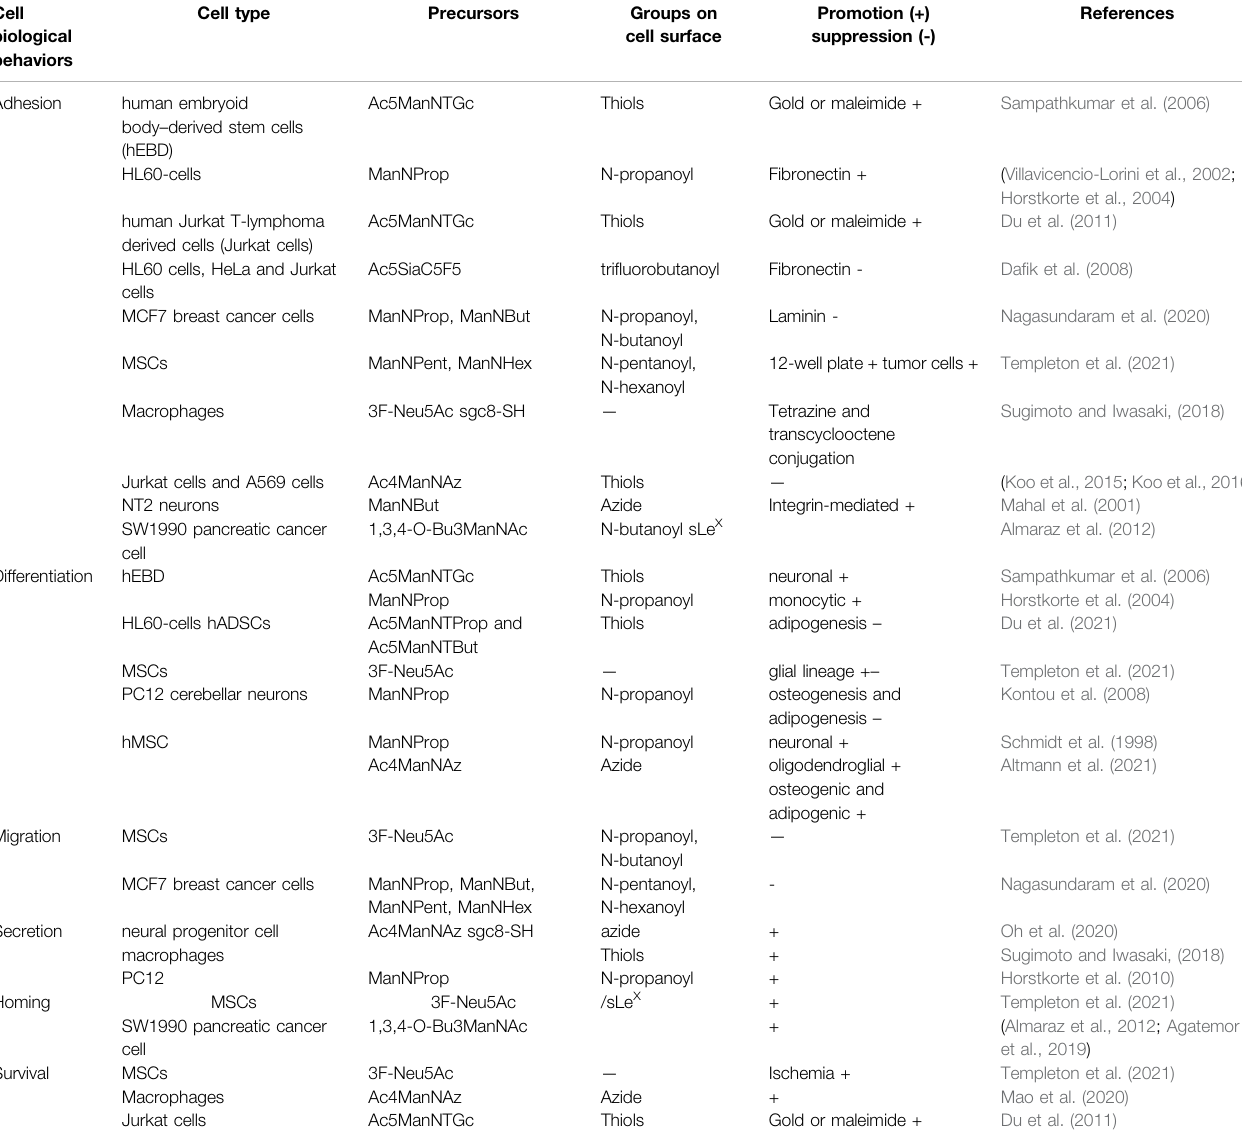
TABLE 1 | The modulation of cell biological behaviors by